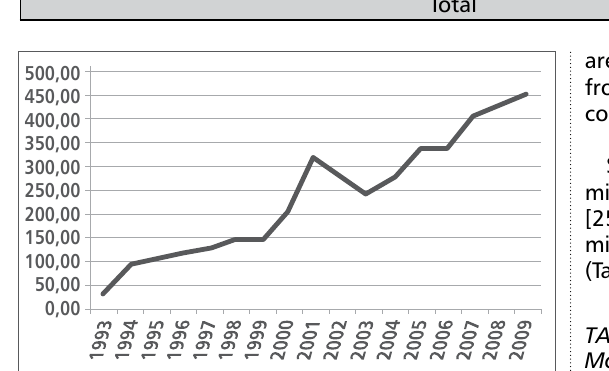
FIGuRE 1 Green tax collection 1993-2009 in million HRK (1 HRK=0,137 € on 30 August